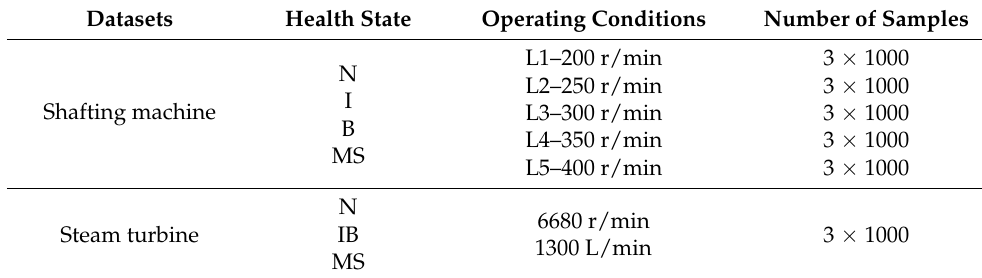
Table 2. Introduction to datasets of lab machines and real-case machines.